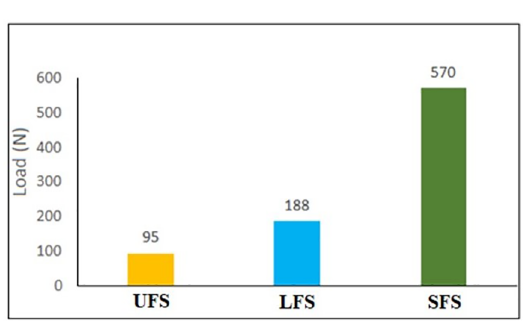
Figure 1. Load capability of carbon fiber reinforced and unreinforced fibers